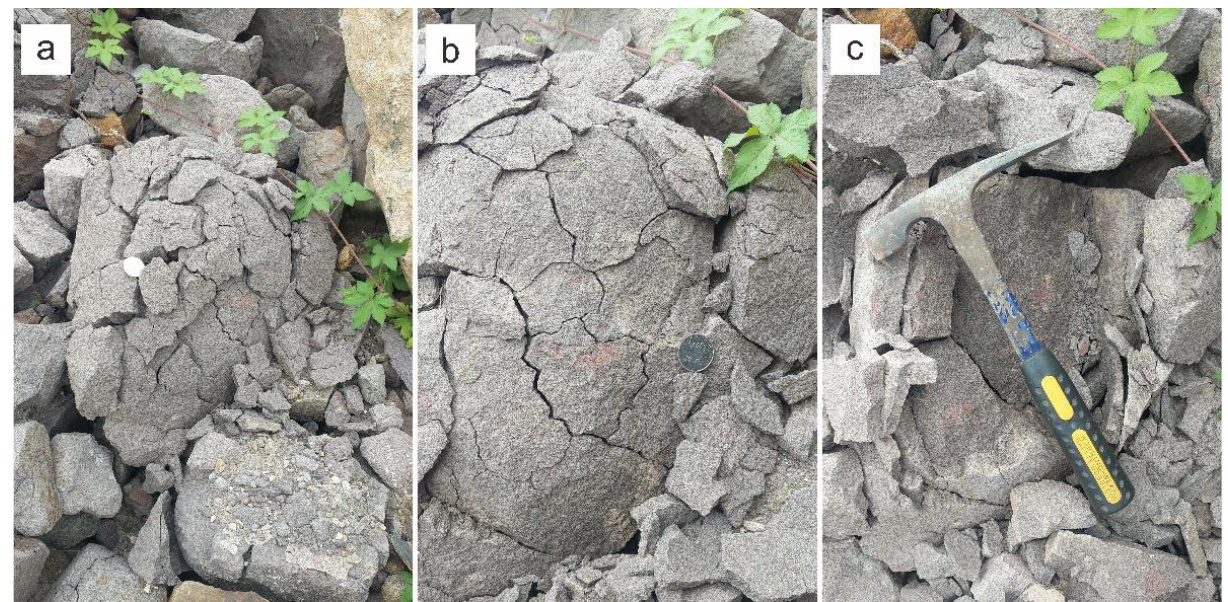
Figure 15. Shrinkage cracks in sandstone at 35°15′52″N and 113°8′15″E in Jiaozuo city: ( a ) the surface; ( b ) middle surface; ( c ) innermost surface.